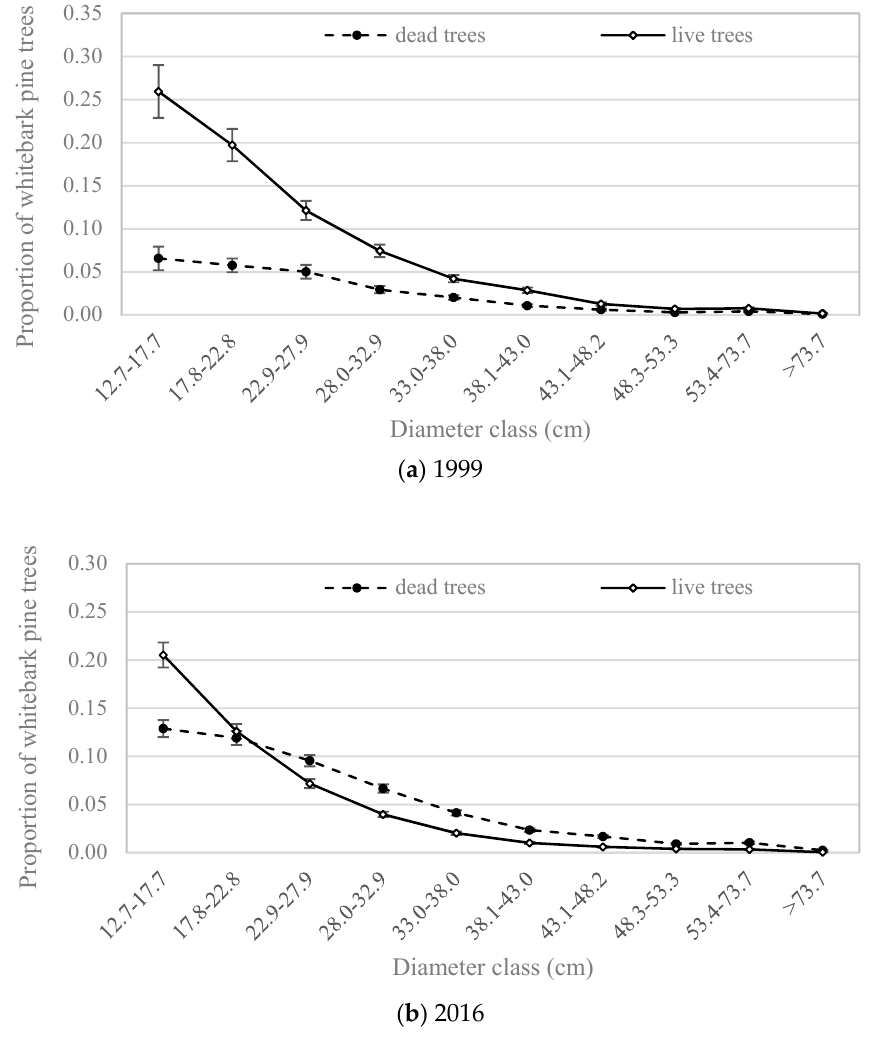
Figure 3. Size-class distributions of live and dead whitebark pine trees with DBH ≥ 12.7 cm in the western US, as estimated at the population scale, from Forest Inventory and Analysis data [23] for two time periods ( a ) 1999, and ( b ) 2016. Y-axes represent the proportion of all trees in each time period. Error bars represent +/ − one standard error [20].